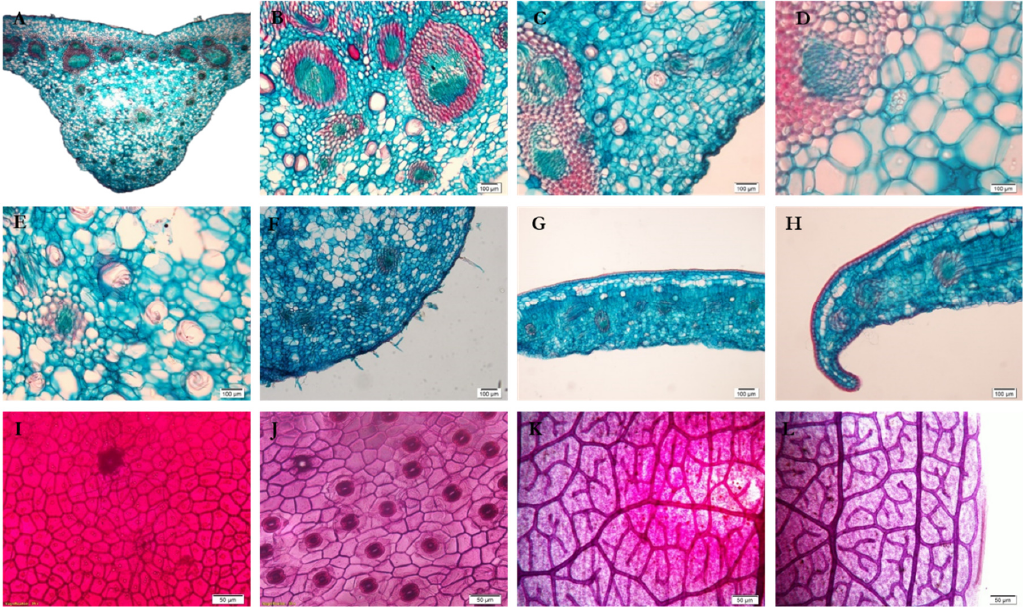
Figure 5. Nepenthes macfarlanei (A) Midrib TS. (B) Close up of vascular bundle. (C) Solitary crystals. (D) Solitary crystals (sand-type). (E) Solitary crystals. (F) Simple, unicellular trichomes. (G) Lamina TS. (H) Margin TS. (I). Adaxial epidermis. (J) Abaxial epidermis with stomata observation. (K) Lamina venation. (L) Margin venation. Bars A, I, J, K, L: 50µm; B, C, D, E, F, G, H: